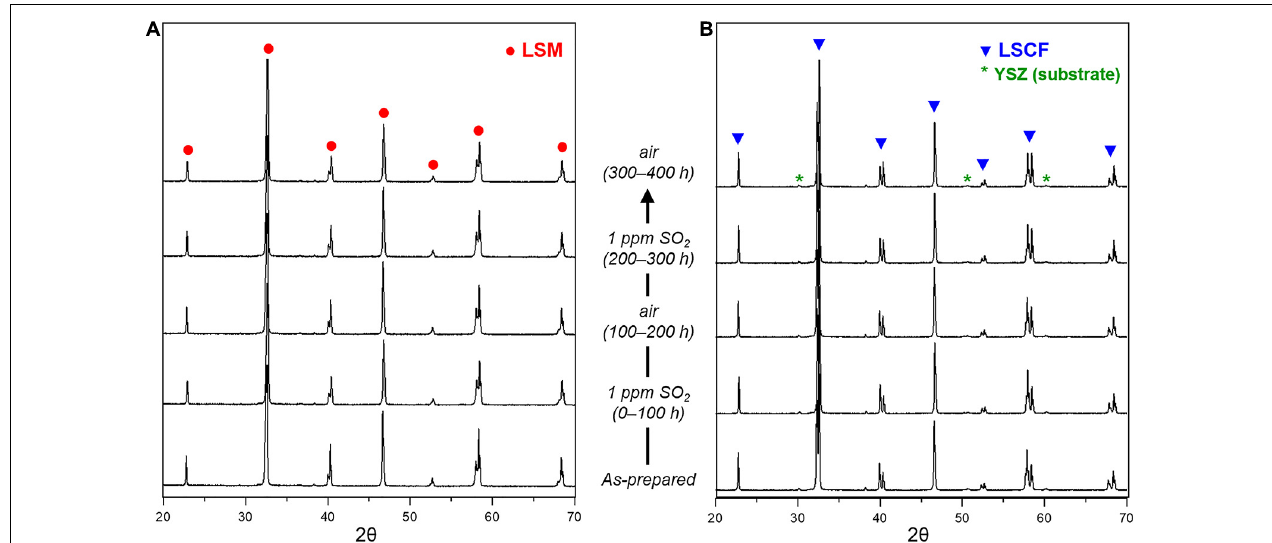
FIGURE 9 | X-ray diffraction patterns of (A) LSM and (B) LSCF exposed to an alternating atmosphere of air and 1 ppm SO 2 (air balance) for 400 h at 700 ◦ C, where YSZ was used as a substrate to support the thin LSM and LSCF layers.